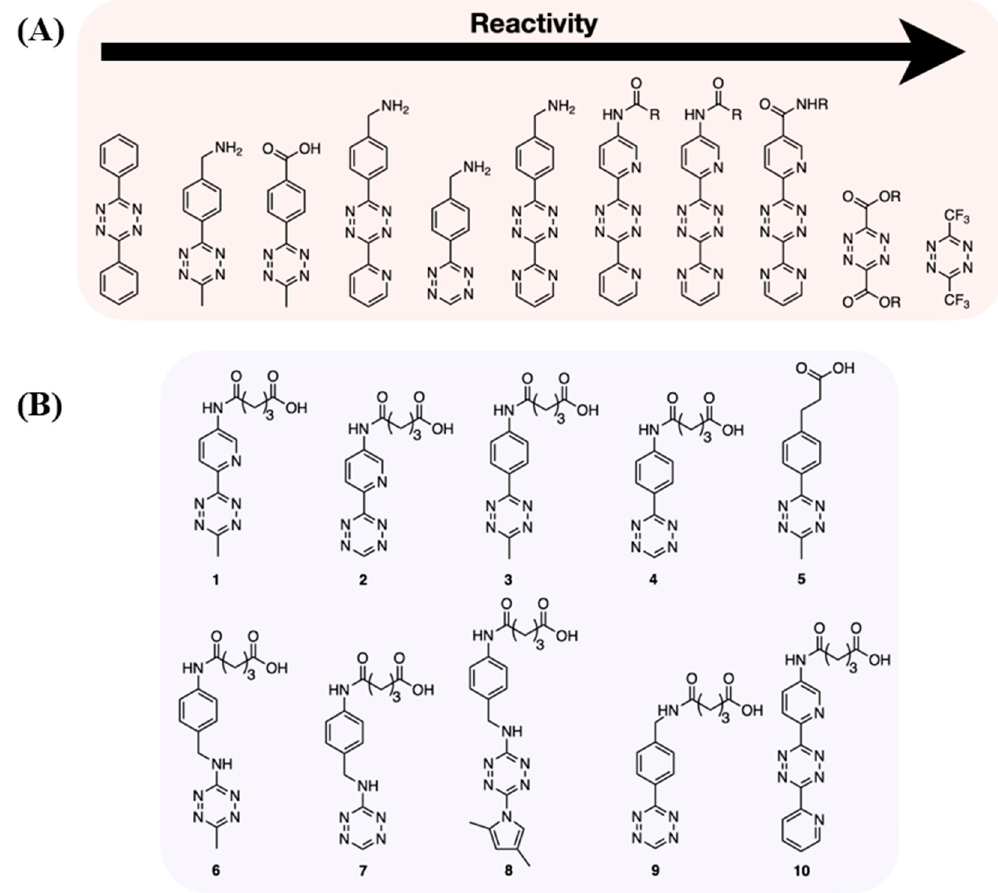
Figure 2. ( A ) Reactivity of different Tz-scaffolds [14] and ( B ) chemical structures of the newly synthesized tetrazine ( 1 – 8 ) and common tetrazines ( 9 , 10 ) [72].